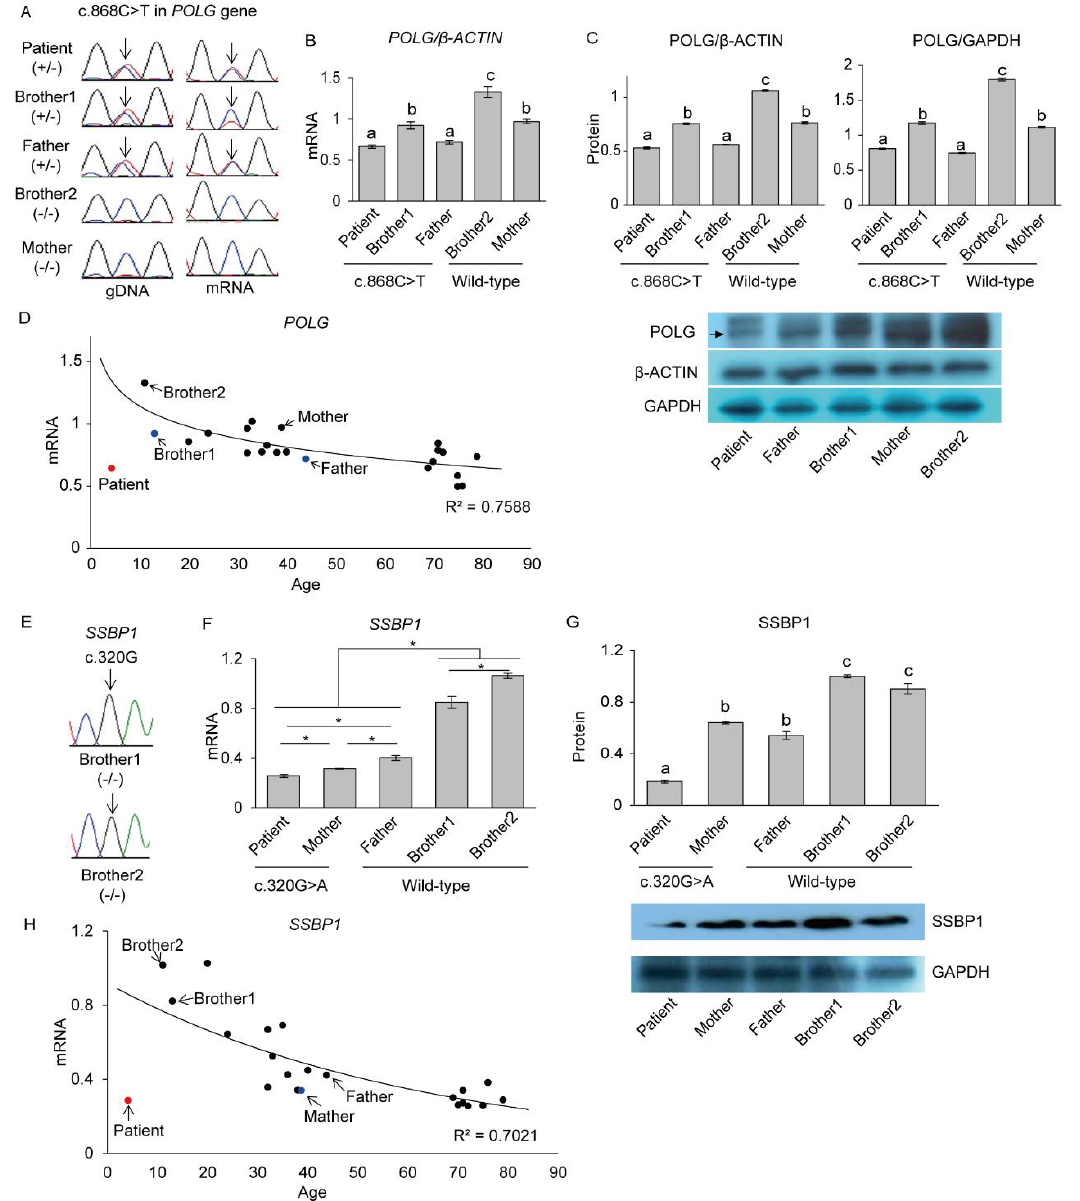
Figure 4. Deficient POLG and SSBP1 expression induced by mutations in the POLG and SSBP1 genes and aging. ( A ) Chro- matograph of position c.868 in the POLG gene. The PS patient, brother 1, and the father showed a c.868 C>T mutation in both genomic DNA and mRNA. ( B ) Deficient POLG mRNA expression induced by POLG mutation and aging. The PS patient and carriers showed lower POLG mRNA expression than the wild-type group when comparing within similar age of family members (PS patient and brother 1 vs. brother 2; father vs. mother). Further, the father showed lower POLG expression than brother 1 in the carrier group, and the mother displayed lower POLG expression than brother 2 in the wild-type group. The relative POLG mRNA expression was normalized by β -ACTIN mRNA. Each assay was completed in triplicate, and the data are represented as the mean ± SEM. The letters a, b, and c indicate significant ( p < 0.05) differences among family members. ( C ) Deficient POLG protein expression induced by POLG mutation and aging. The PS patient and carriers showed lower POLG protein expression than the wild-type group when comparing within similar age of family members (PS patient and brother 1 vs. brother 2; father vs. mother). The father showed lower POLG expression than brother 1 in the carrier group, and the mother displayed lower POLG expression than brother 2 in the wild-type group. The arrow in a blot of POLG indicates the bands that were quantified for relative expression. The relative POLG protein expression was normalized by β -ACTIN and GAPDH protein. Each assay was completed in triplicate, and the data are represented